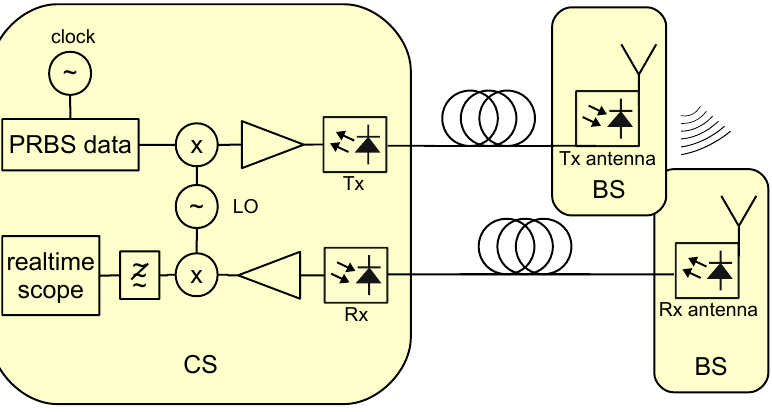
Figure 7. Block diagram of experimental